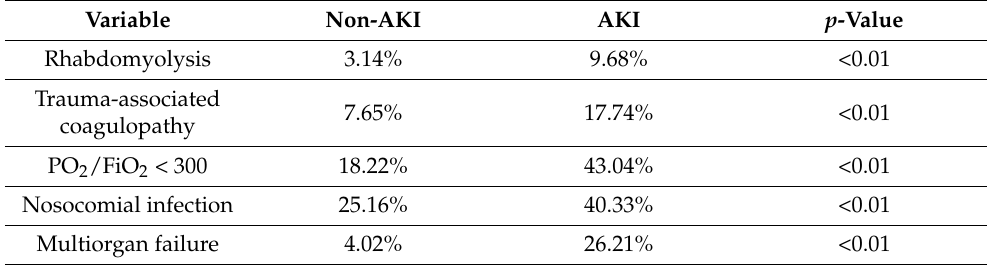
Table 2. The distribution of complications in isolated TBI patients distributed by the existence of AKI. Variable